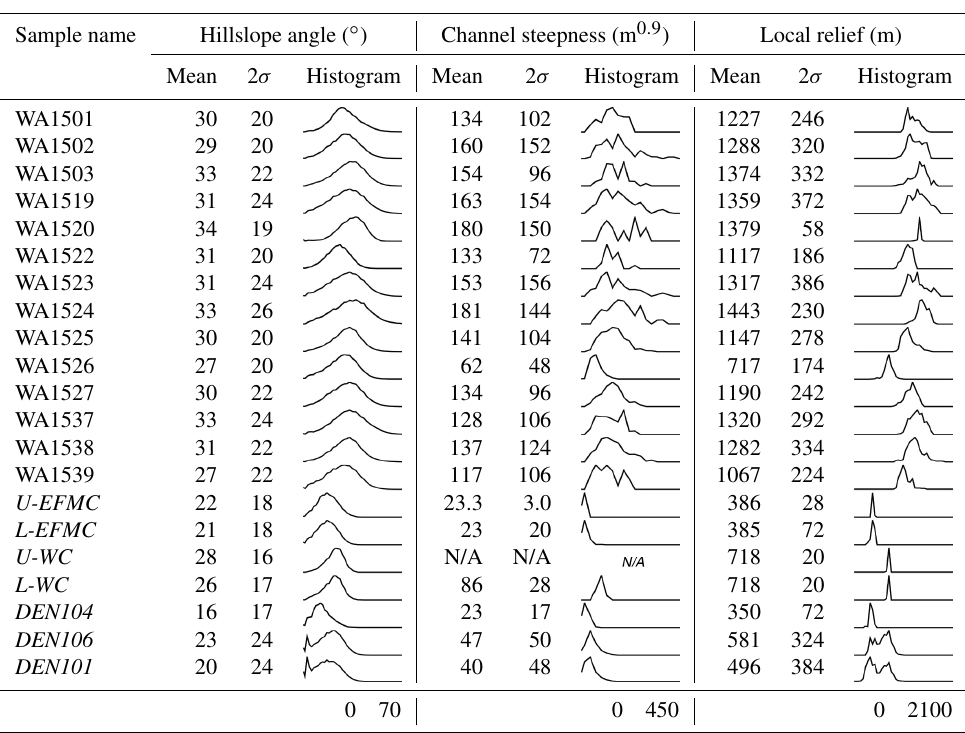
Table 2. Basin metrics for erosion processes. 2 σ = 2 standard deviations on the mean. Curves represent simplified histograms with normal- ized counts. See labels below each column for minimum and maximum bin values. Basins in italics are from Belmont et al. (2007). Values exclude data from ice-covered regions.